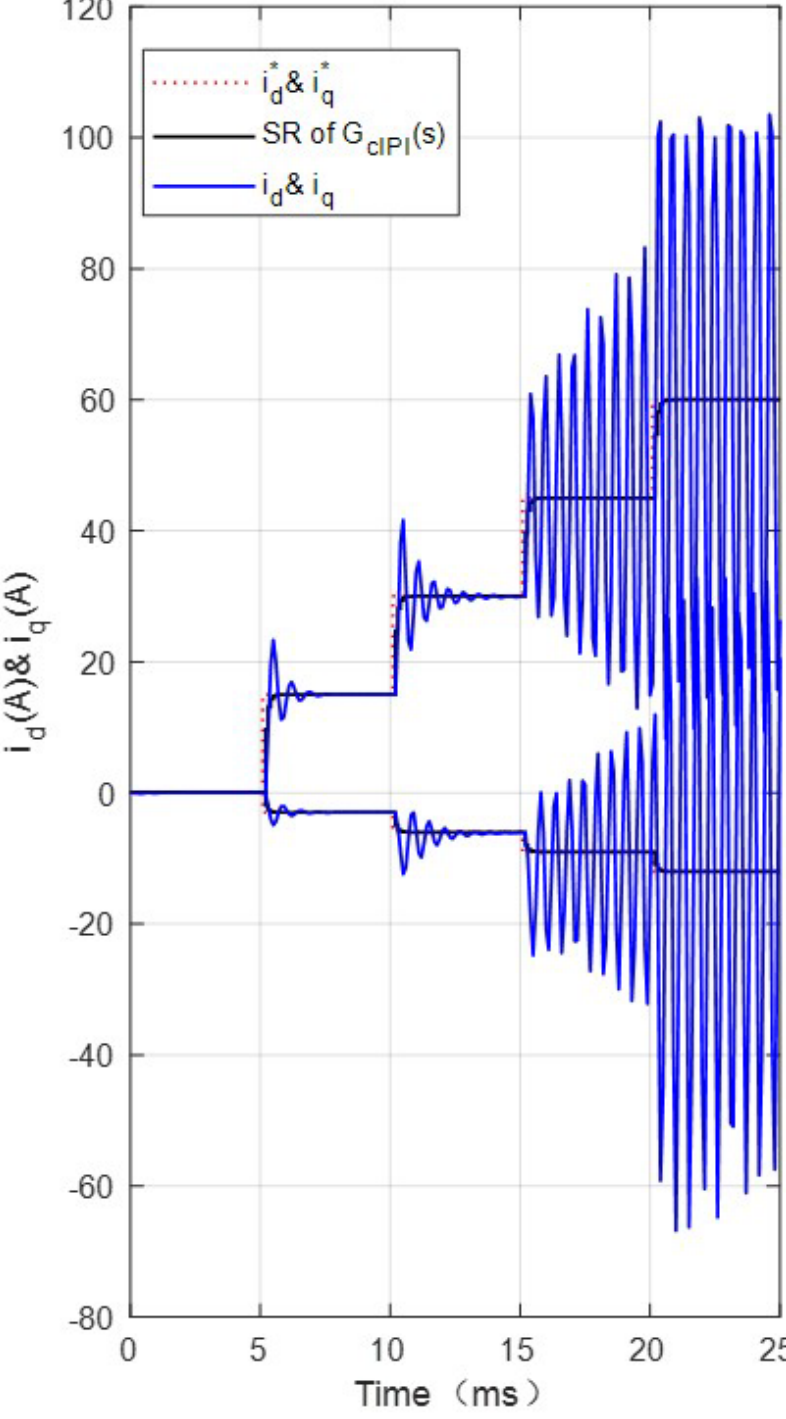
Figure 12. Simulation result of PI controller based on DIMC ( α = 6473 rad/s, f s = 10 kHz) of the high-speed saturated machine ( f out = 833 Hz